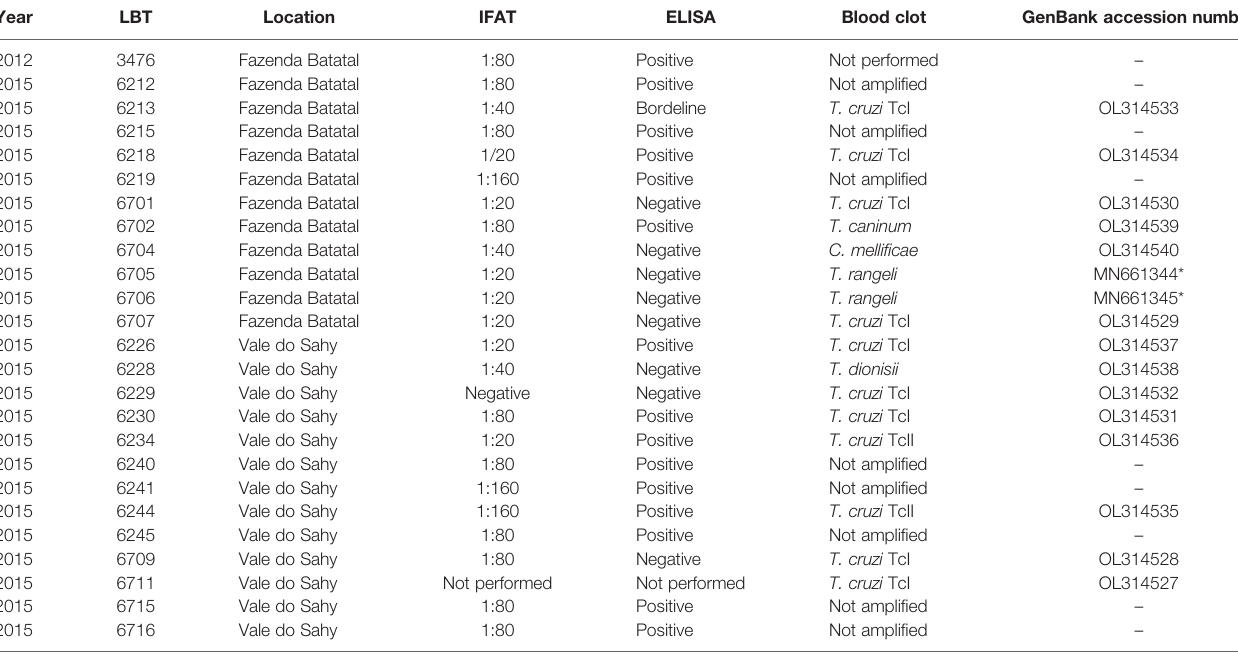
*Sequence previously published by Dario et al. (2021a).